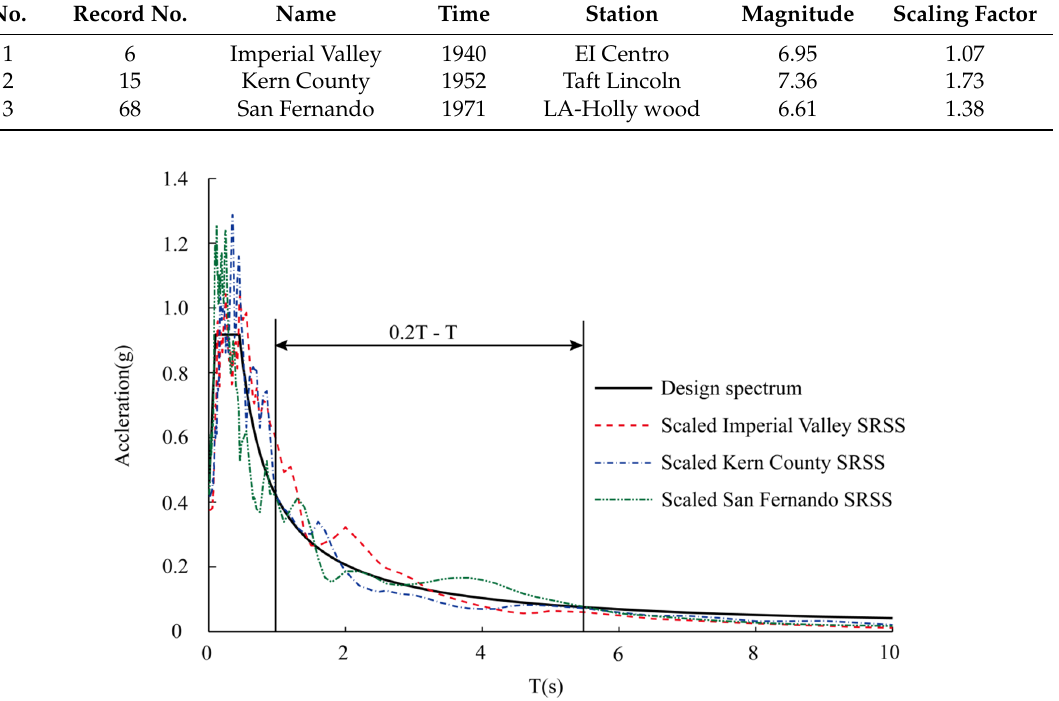
Figure 3. Scaling SRSS spectrum of the earthquake records.